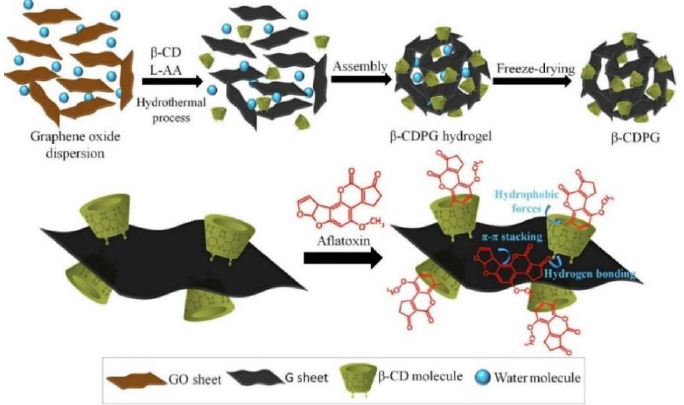
Figure 5. Schematic representation of the process to prepare porous graphene functionalized with β -CD and its interactions with a typical aflatoxin molecule (adapted and reprinted with permission from reference